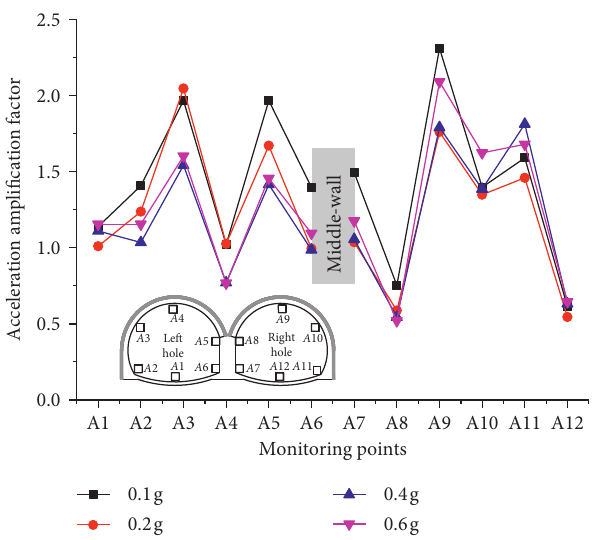
Figure 12: Variation trends of AAF of WC-Z in the Z -direction.